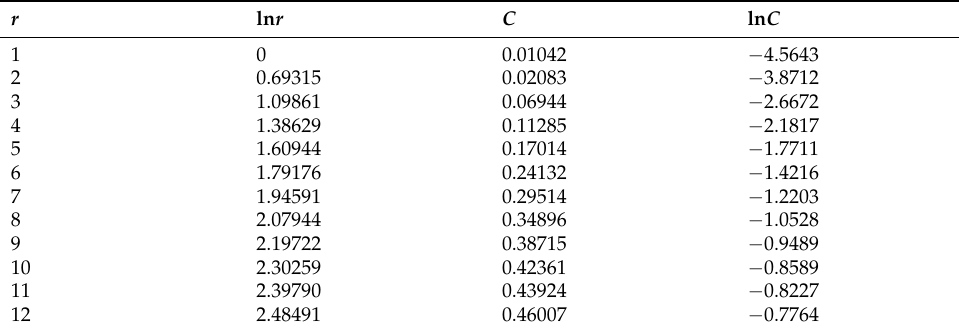
Table A9. Measurements for park system crow correlation dimension.